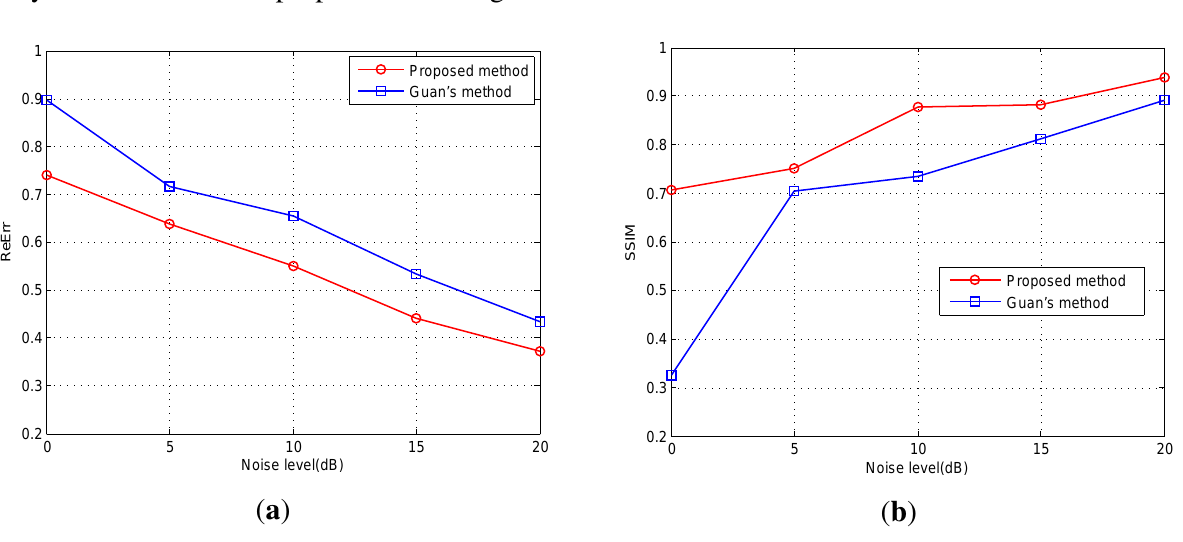
( a ) Evolution of the relative error (ReErr) along the noise SNRs for the simulations; ( b ) Evolution of the structure similarity (SSIM) along the noise SNRs for the